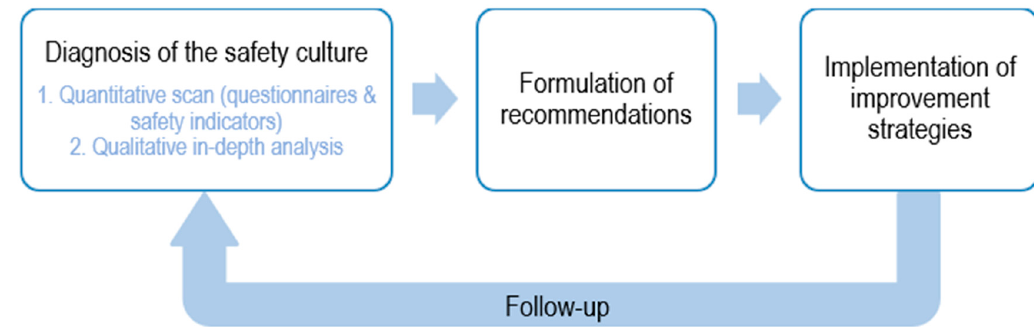
Figure 4. ISCA-approach—steps in the assessment of the safety